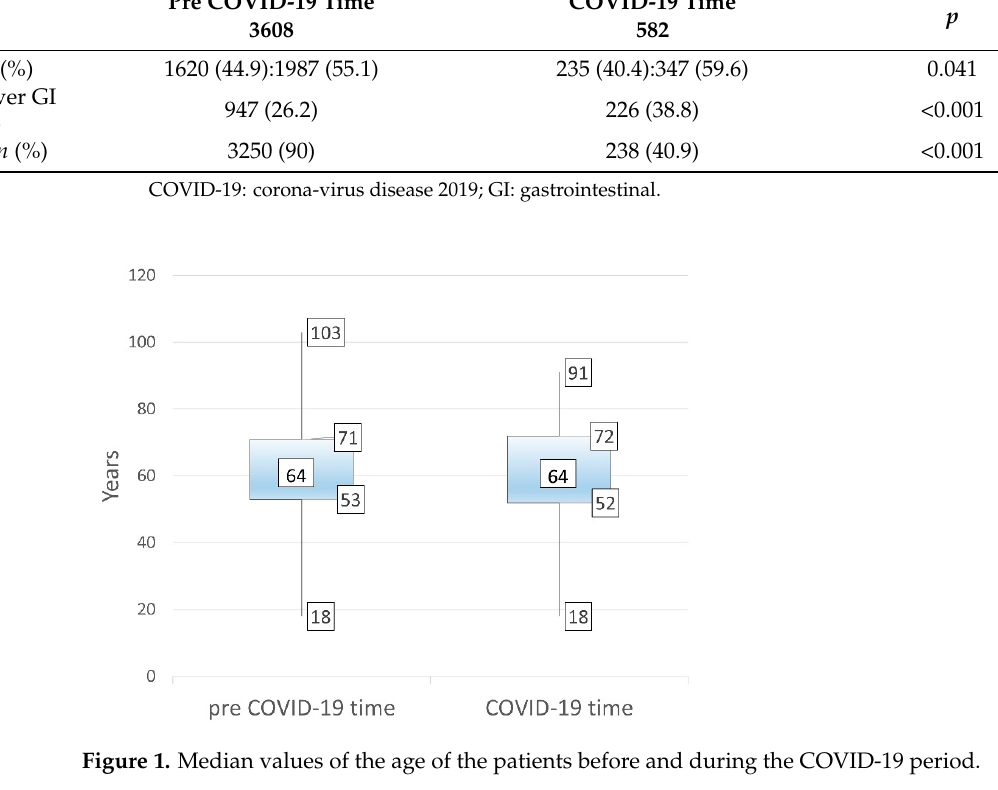
. Figure 2. Impact of COVID-19 on the numbers of endoscopic procedures.